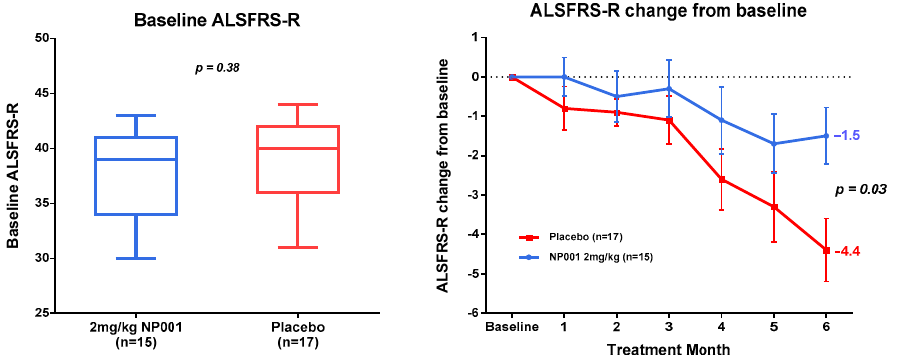
Figure 1. ALSFRS-R values at baseline and in response to NP001 or placebo at 6 months in those with plasma CRP > 1.13 mg/L at baseline . A comparison of baseline ALSFRS-R scores is on the left side. No statistically significant differences were found between NP001 treated and Placebo groups (Wilcoxon test, p = 0.38). ALSFRS-R score change from baseline is on the right side: ALSFRS-R score change from baseline for participants treated with NP001 ( n = 15) depicted in blue and compared to the placebo group ( n = 17) depicted in red. The plots represent the mean of ALSFRS-R score change from baseline ± SEM (standard error of the mean). Participants treated with NP001 experienced a slower decline in ALSFRS-R score from baseline compared to treatment with placebo and showed a 66% slower progression rate by the end of study (Wilcoxon test, p = 0.03).